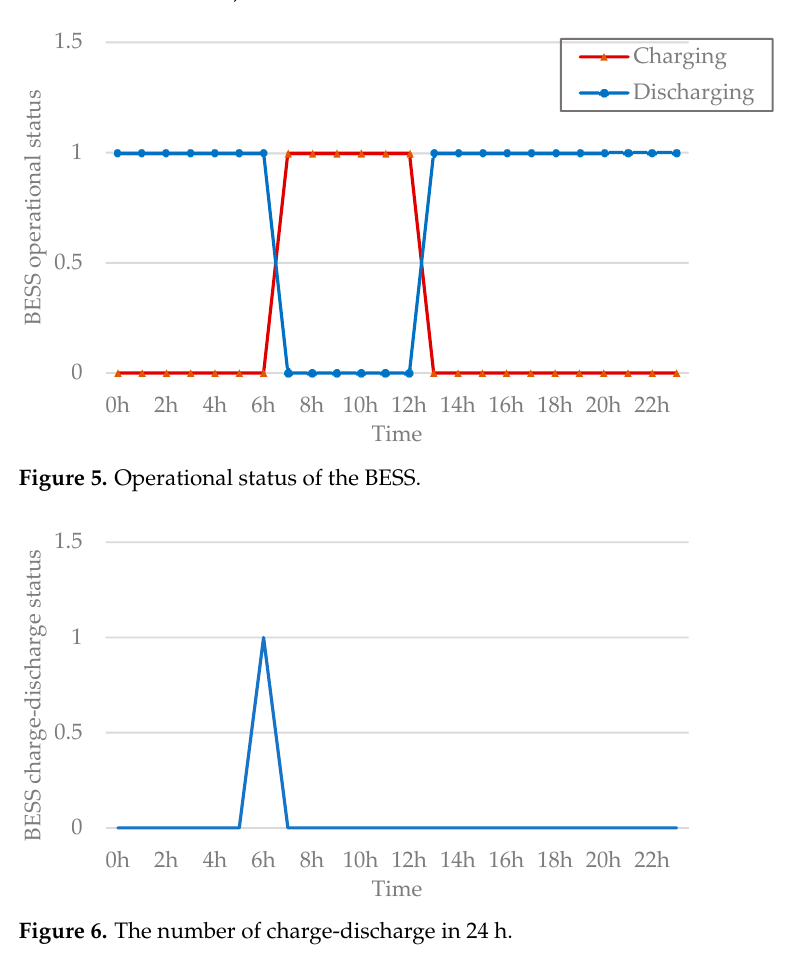
Figure 6. The number of charge-discharge in 24 h.